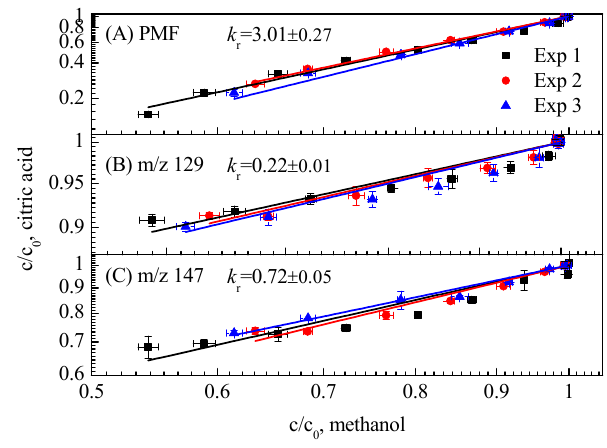
Figure 5. Changes in the relative concentration of (a) methanol, (b) citric acid extracted with PMF analysis and (c) specific tracers measured with the AMS during the OH-initiated oxidation of citric acid. Experimental conditions are D m : 140nm, RH: 30 ± 3%, T : 298K. The values in the top row represent the OH exposures.